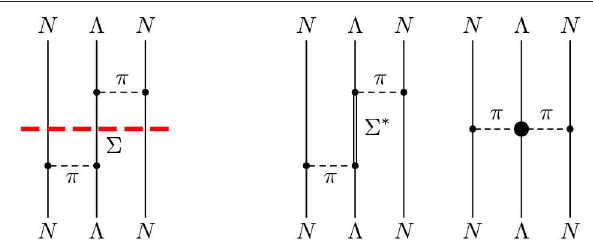
FIGURE 4 | Examples for reducible (left) and irreducible (right) three-baryon interactions for 3 NN . The thick dashed line cuts the reducible diagram in two two-body interaction